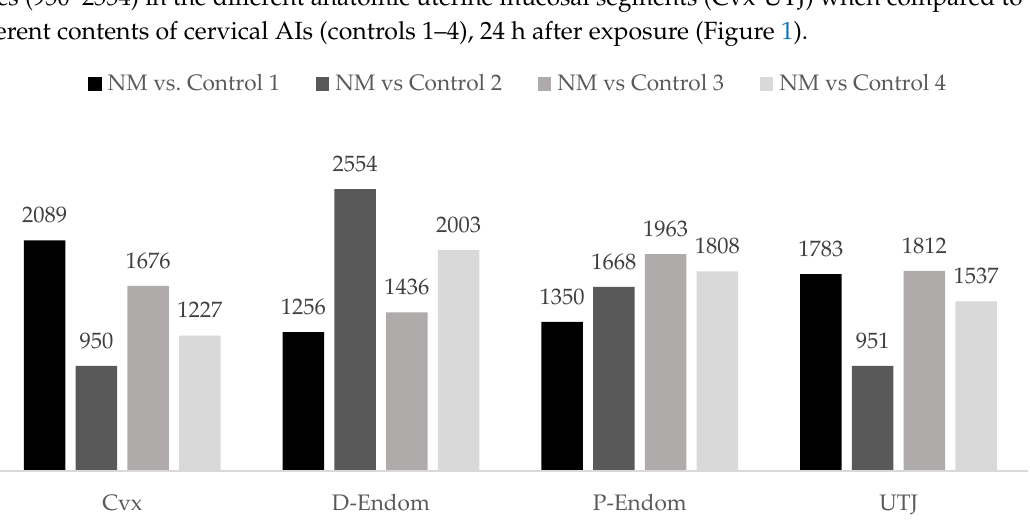
Figure 1. Differential expression of annotated genes in the mucosa of the uterus (endocervix (Cvx), endometrium (distal: D-Endom or proximal: P-Endom) and the utero-tubal junction (UTJ)) of sows induced by natural mating (NM) when compared to cervical AI of different contents; control 1: semen, control 2: seminal plasma from the sperm-peak fraction, control 3: seminal plasma from the entire ejaculate, control 4: sham–AI with BTS extender; negative control. The numbers represent the number of differentially expressed genes ( p -value < 0.05).